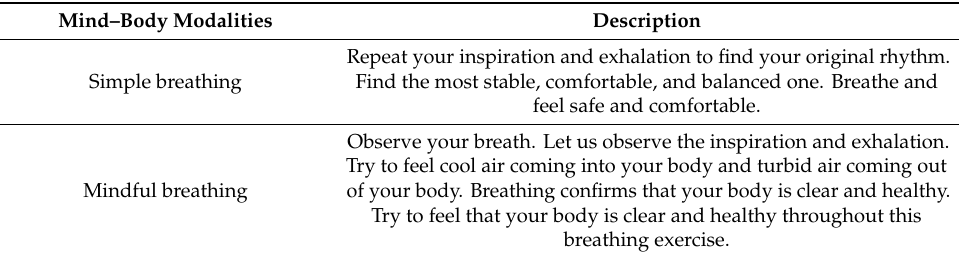
Table 4. Mind–body modalities for symptom